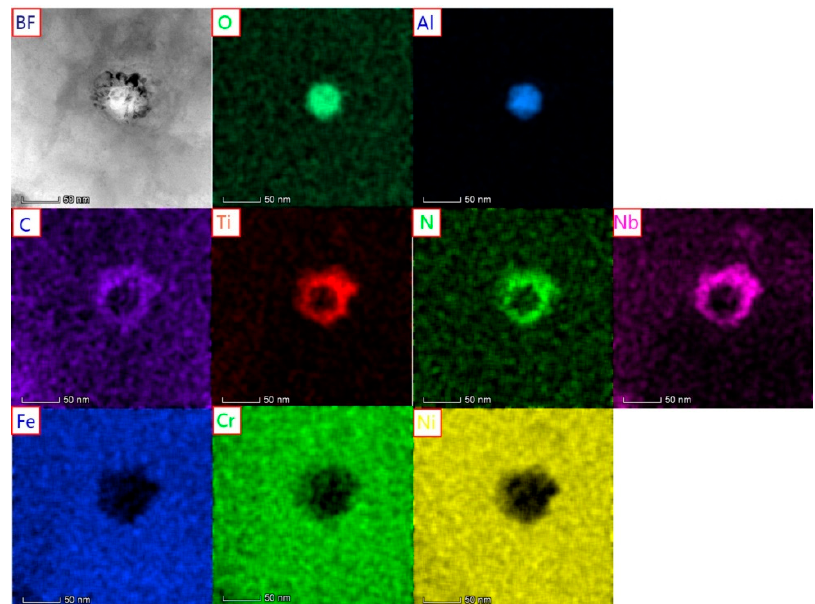
Figure 8. Bright-field transmission electron microscopy (TEM) image of the entrapped Al 2 O 3 by MX and element distribution mapping in this field.